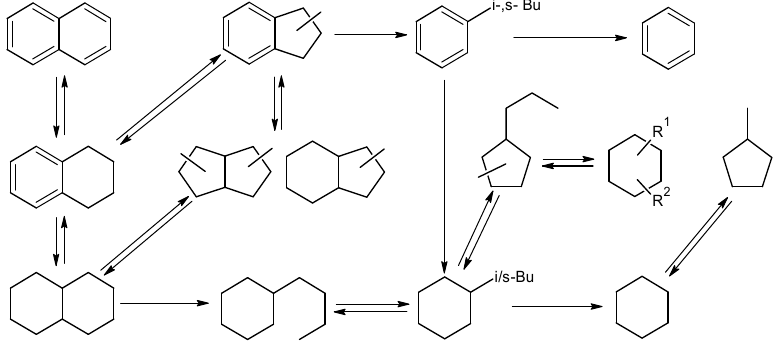
Figure 7. The proposed monomolecular reaction mechanism of naphthalene hydrogenation ‐ hydrocracking reactions.